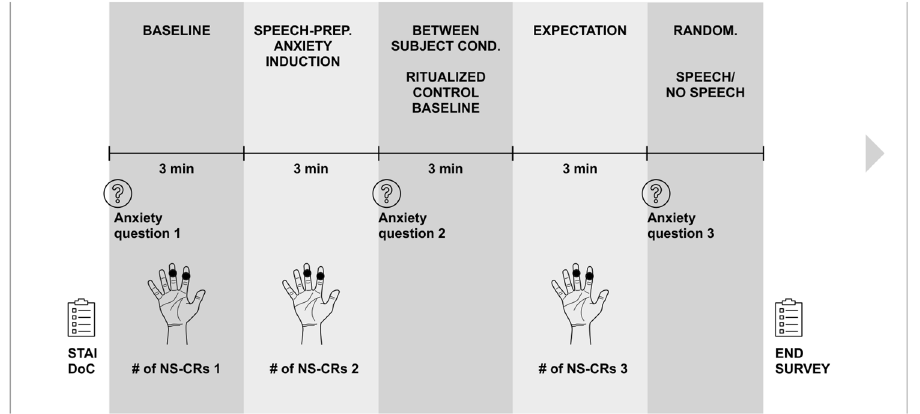
Figure 2. Procedure overview. Our main analyses compared anxiety decrease between the speech-preparation (measure 2) and expectation (measure 3) periods while holding constant the individual baseline anxiety levels (measure 1). NS-SCRs = Non-Specific Skin Conductance Responses; STAI = State-Trait Anxiety Inventory; DoC = Desirability of